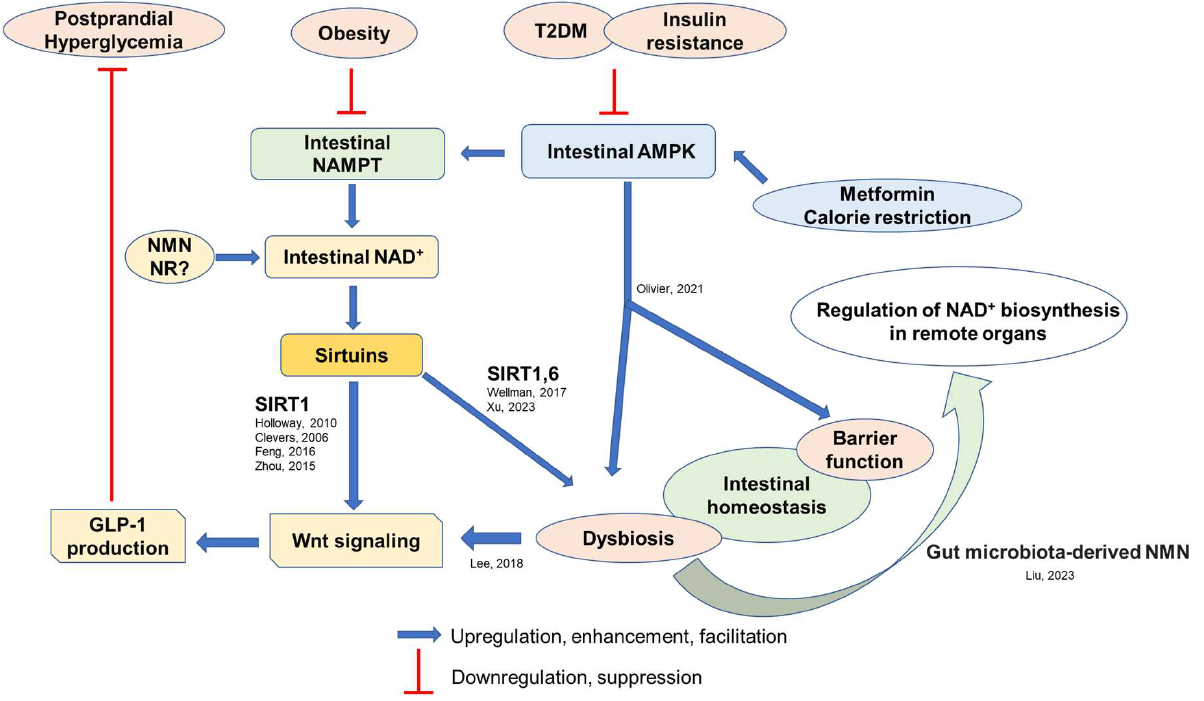
Figure 3. Vicious cycles of metabolic disorders by disrupting intestinal AMPK–NAMPT–NAD–SIRT1–gut microbiota–Wnt signaling–GLP-1 axis [98,101,115–121]. NMN—nicotinamide mononucleotide; NR—nicotinamide riboside; Wnt—wingless-related integration site; GLP-1—glucagon-like